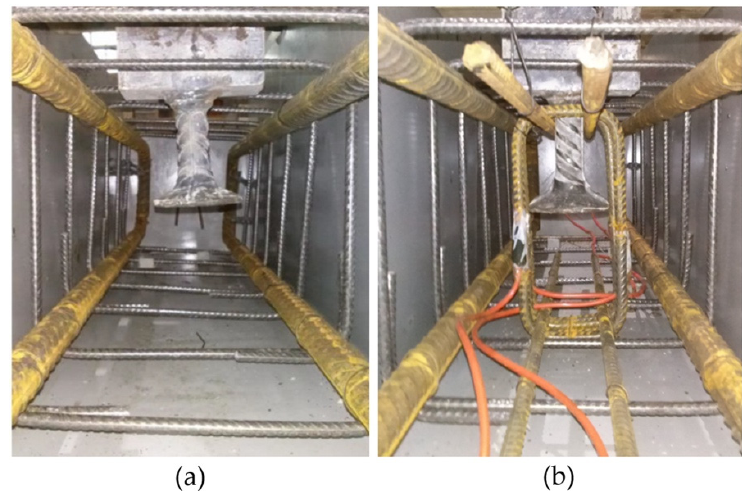
Figure 4. Specimens before casting: ( a ) specimen without supplementary reinforcement; ( b ) specimen with supplementary reinforcement.